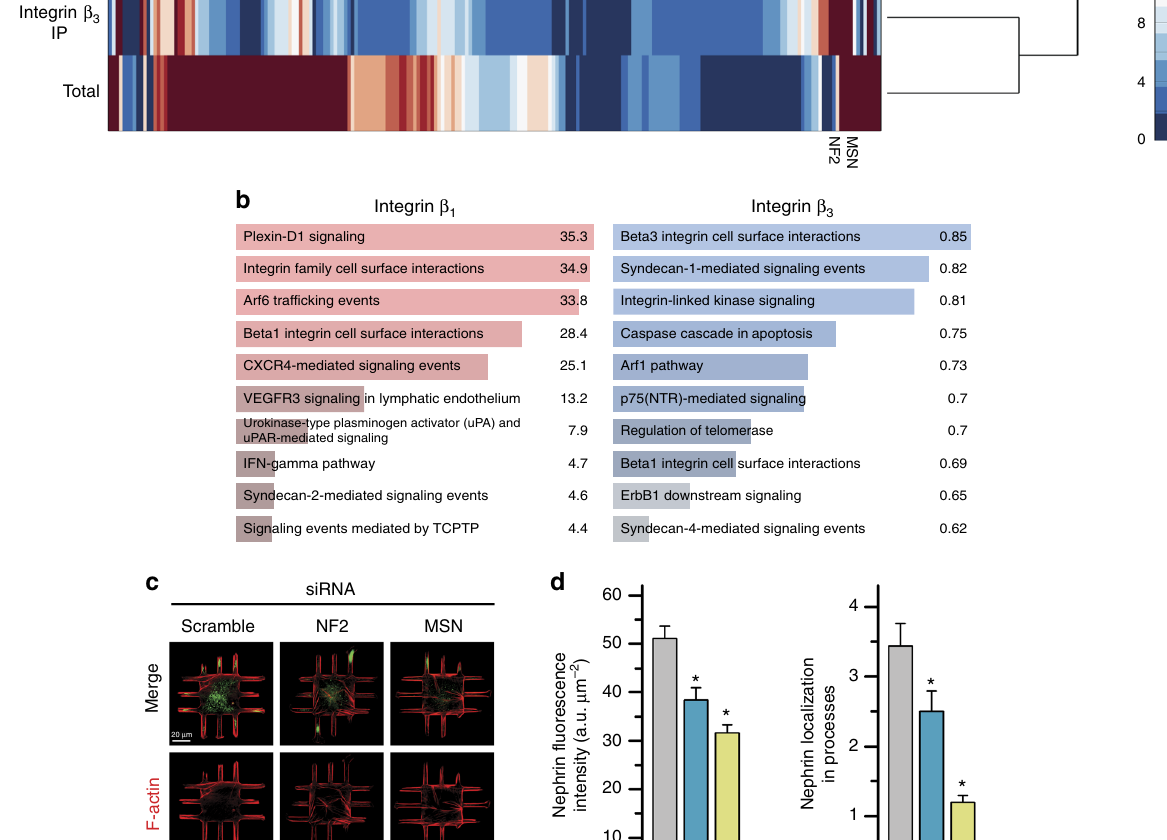
the levels of integrin β 1 and β 3 , we used label-free proteomics